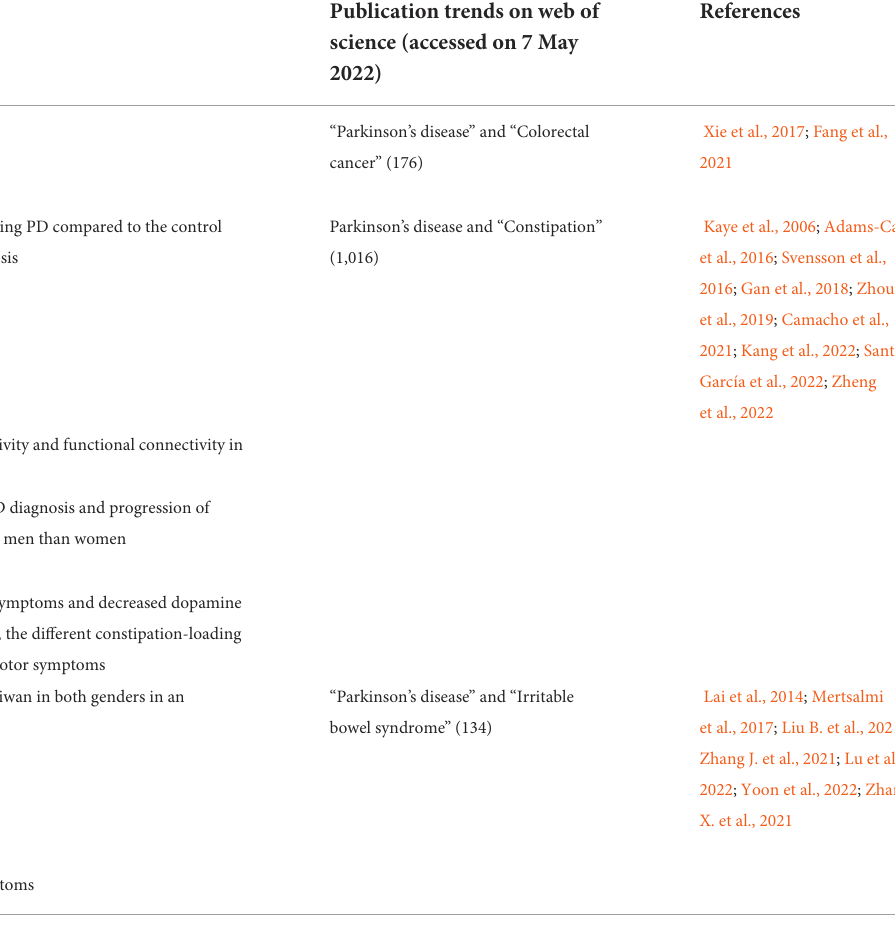
TABLE 1 The association between Parkinson’s disease and intestinal